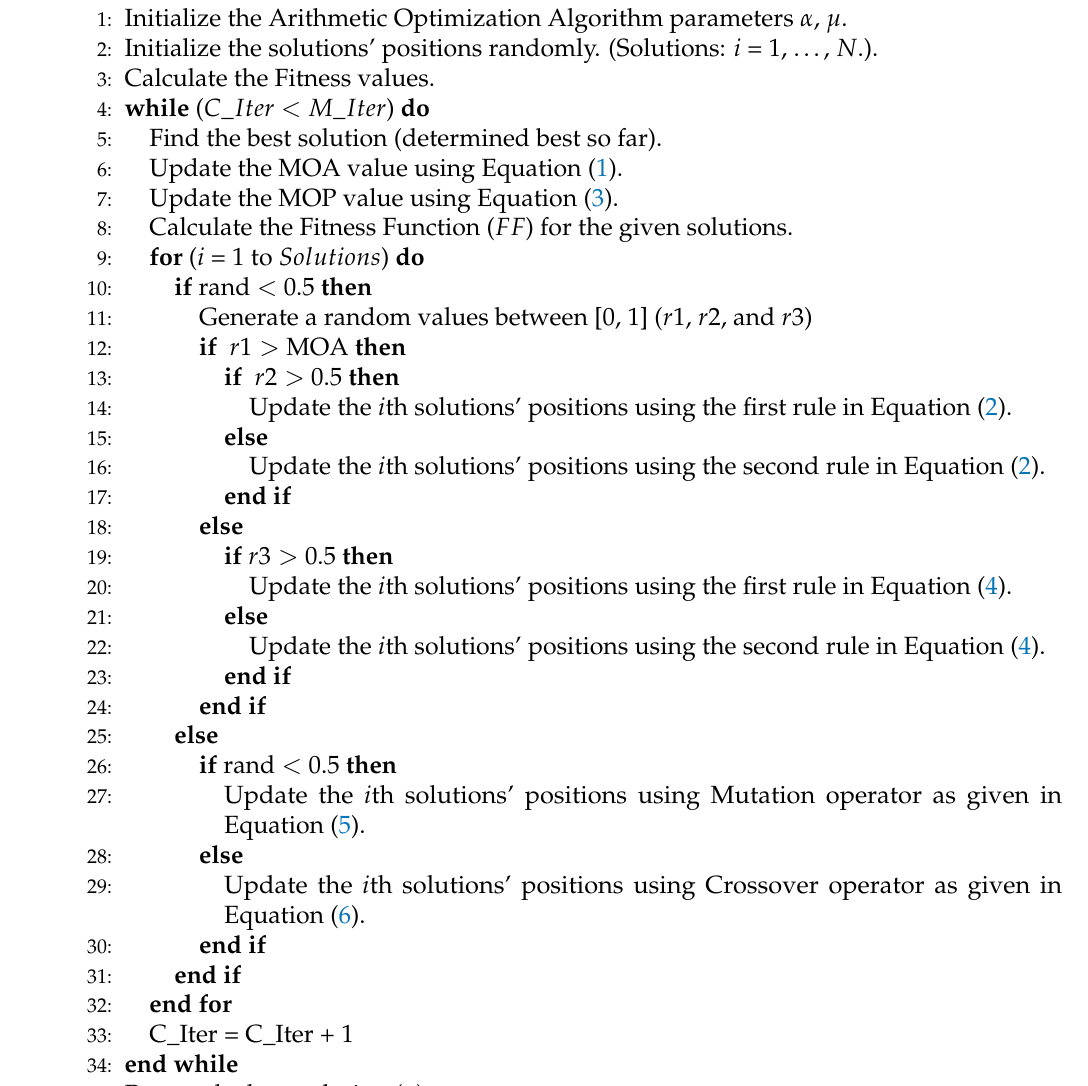
Figure 3. The flowchart of the proposed DAOA. Algorithm 1 Pseudo-code of the DAOA